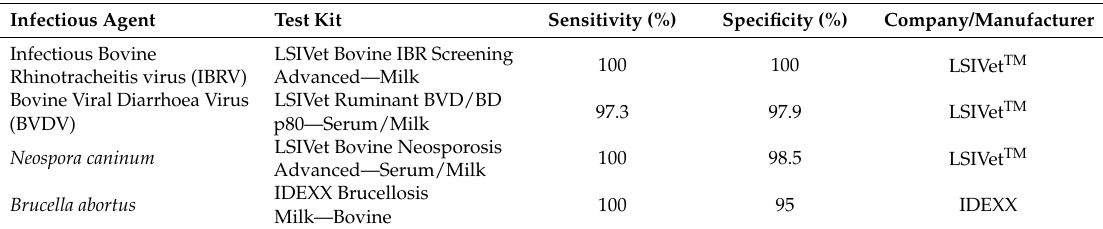
Table 1. ELISA kits used for the detection of antibodies against four bovine infectious agents. Infectious Agent